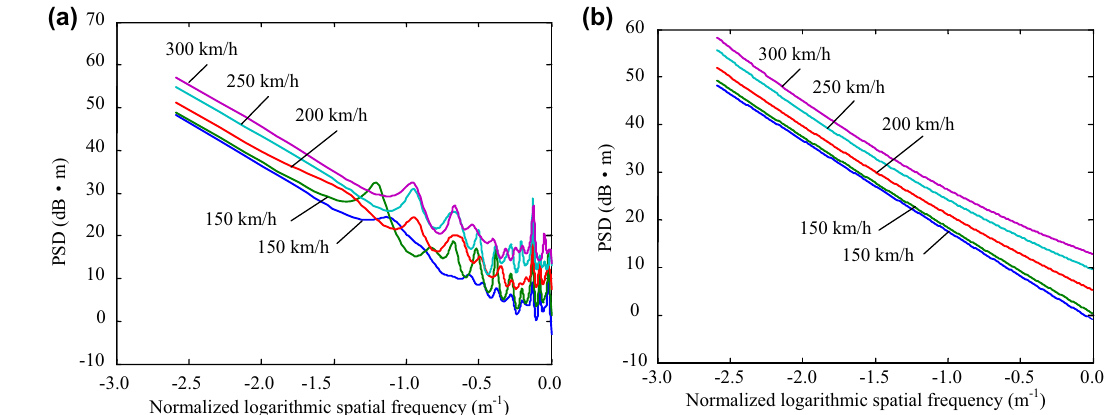
Fig. 14 Contact force spectrum ( a ) and fitting results under the train speed from 100 to 300 km/h (